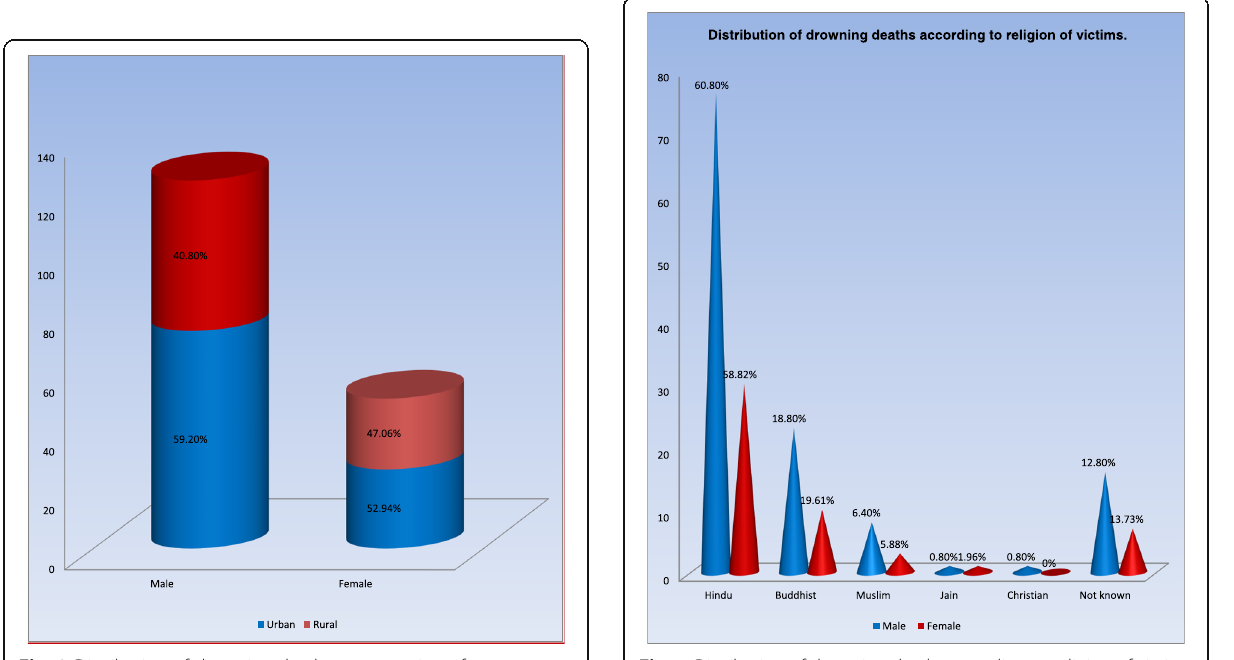
Fig. 4 Distribution of drowning deaths according to religion of